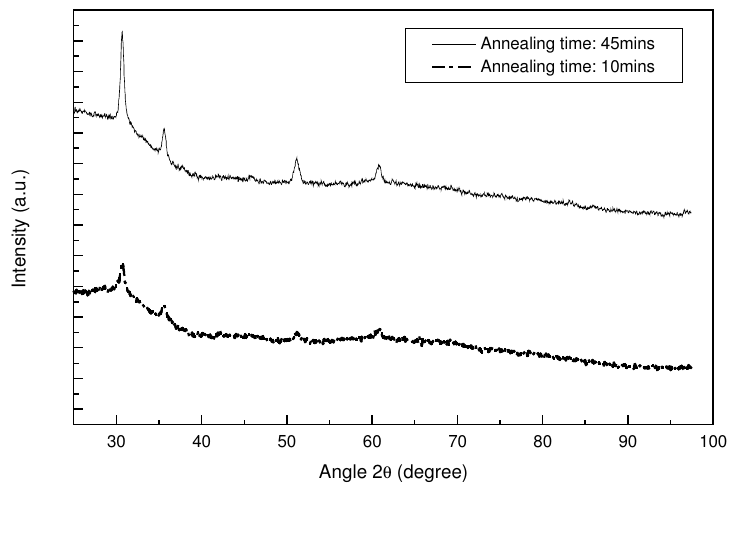
Figure 3 . XRD results of samples prepared by different annealing